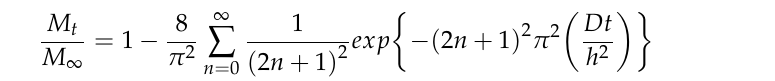
where t is the time the samples were immersed in water, M t is the quantity of water absorption during time t and M ∞ is the corresponding quantity of water absorption during the infinite time, i.e., the saturation level. Moreover, D is the diffusion coefficient and h is the whole thickness of the plane sheet (3 mm). As expressed by the above equations, the moisture absorption in single-phase diffusion can be expressed in terms of two parameters: D and M ∞ . They depend strongly on the nature of the material, relative humidity, and temperature. Formula (2) can be simplified for short- and long-term time approximations as: